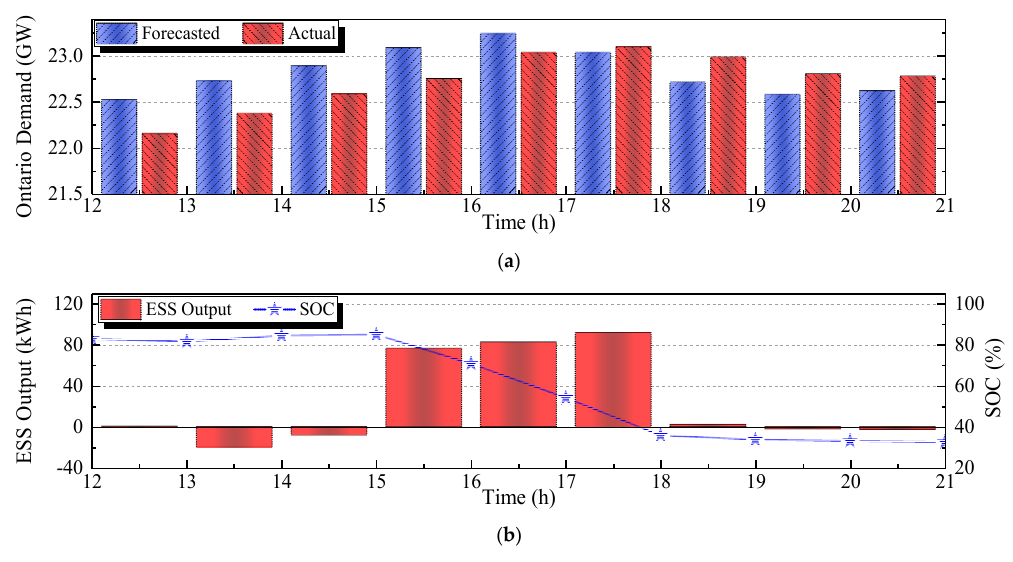
Figure 8. Actual operation results for August 10, 2016: ( a ) forecasted and actual Ontario demands; ( b ) output and SOC of the ESS.